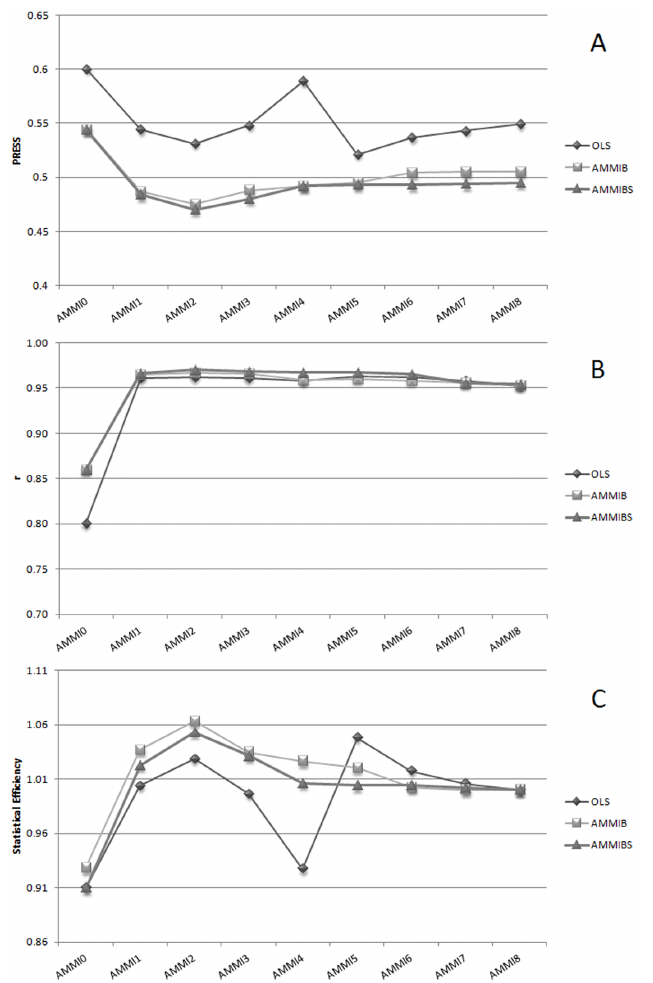
Fig 9. Ockham's plot related to classical AMMI model (OLS), Bayesian AMMI (AMMIB) and Bayesian Shrinkage AMMI (AMMIBS). (A) AMMI vs prediction sum square- PRESS (lowest is best — Ockham's valley); (B) AMMI vs correlation (r) between "true" and predicted cell values in GEI matrix; (C) AMMI vs Statistical Efficiency (higher is best — Ockham's